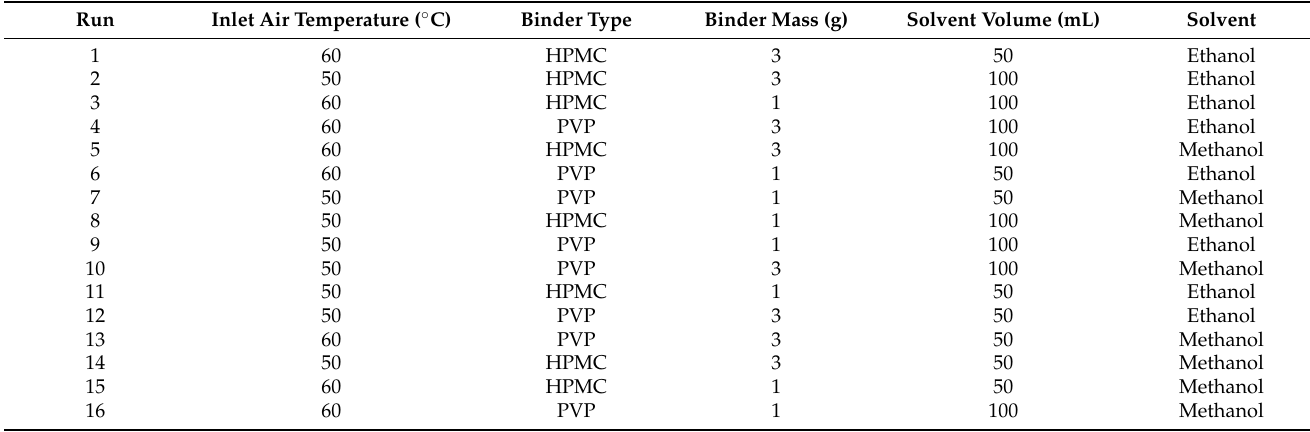
Table 1. Runs generated for the 2-level 5-factorial DoE